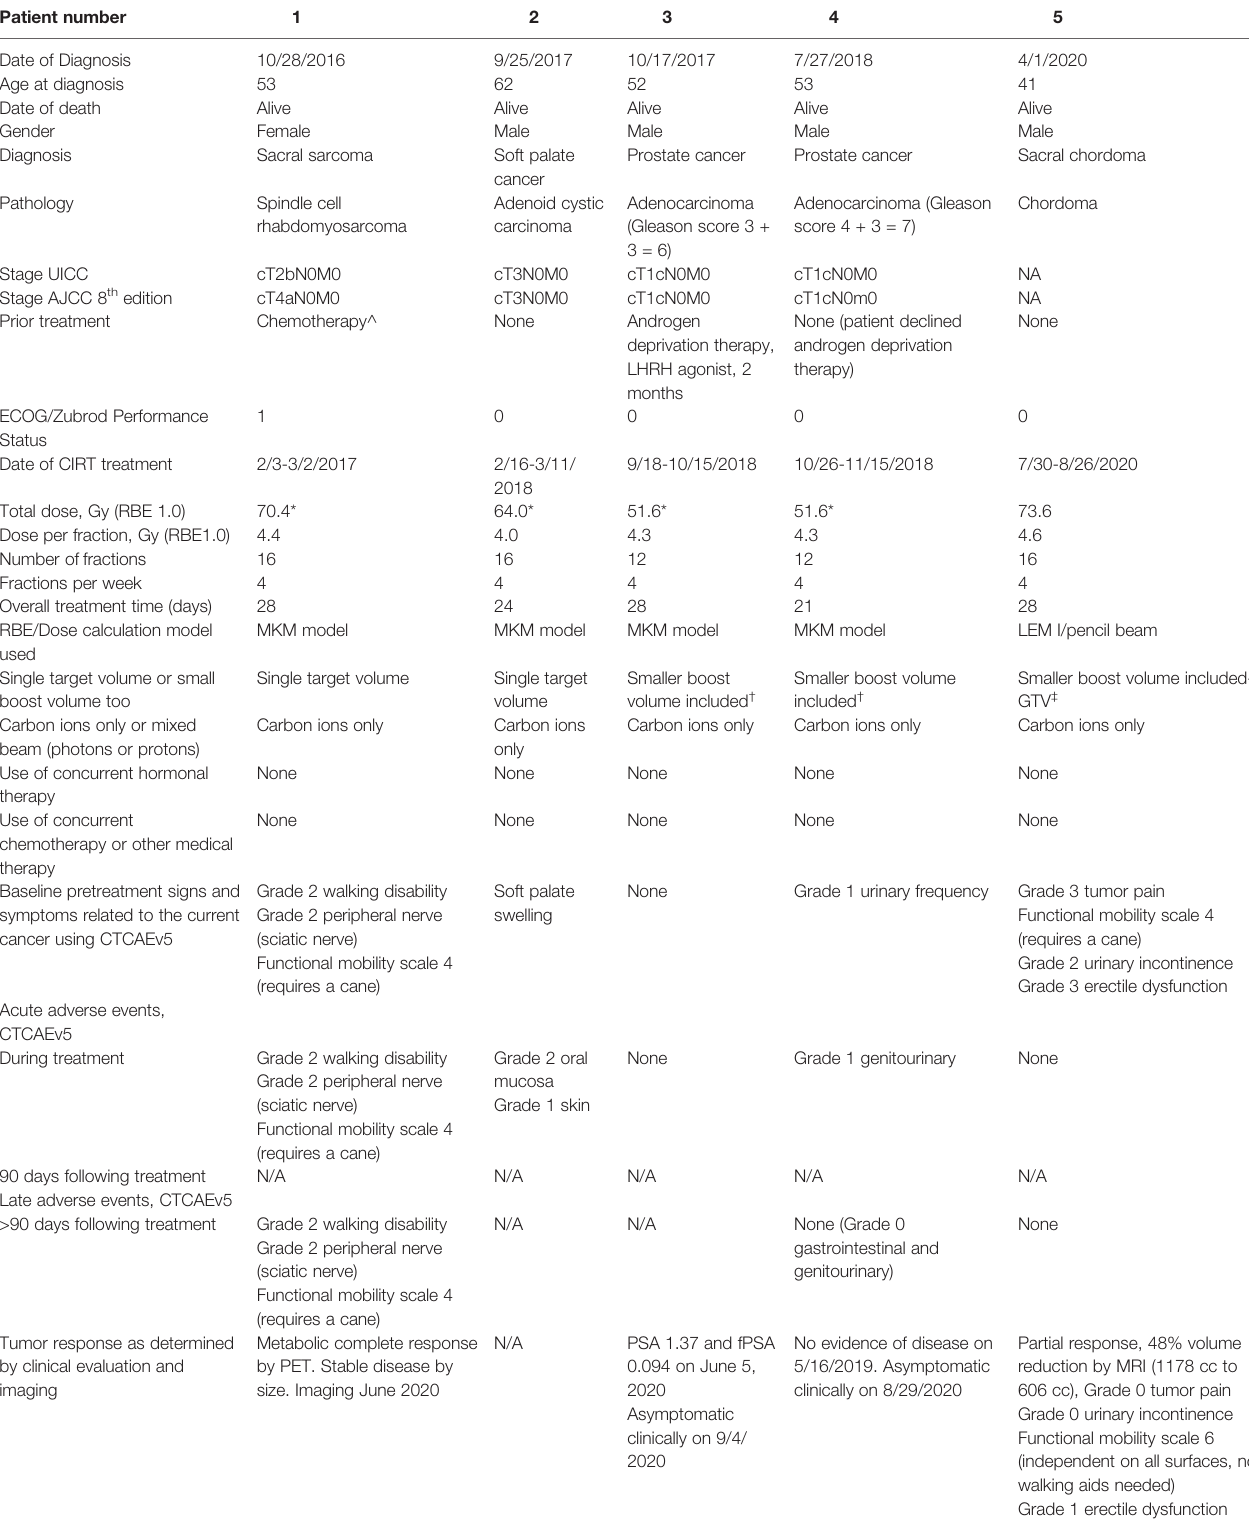
TABLE 1 | Patient demographics, diagnosis, staging, treatment, and outcomes. Patient